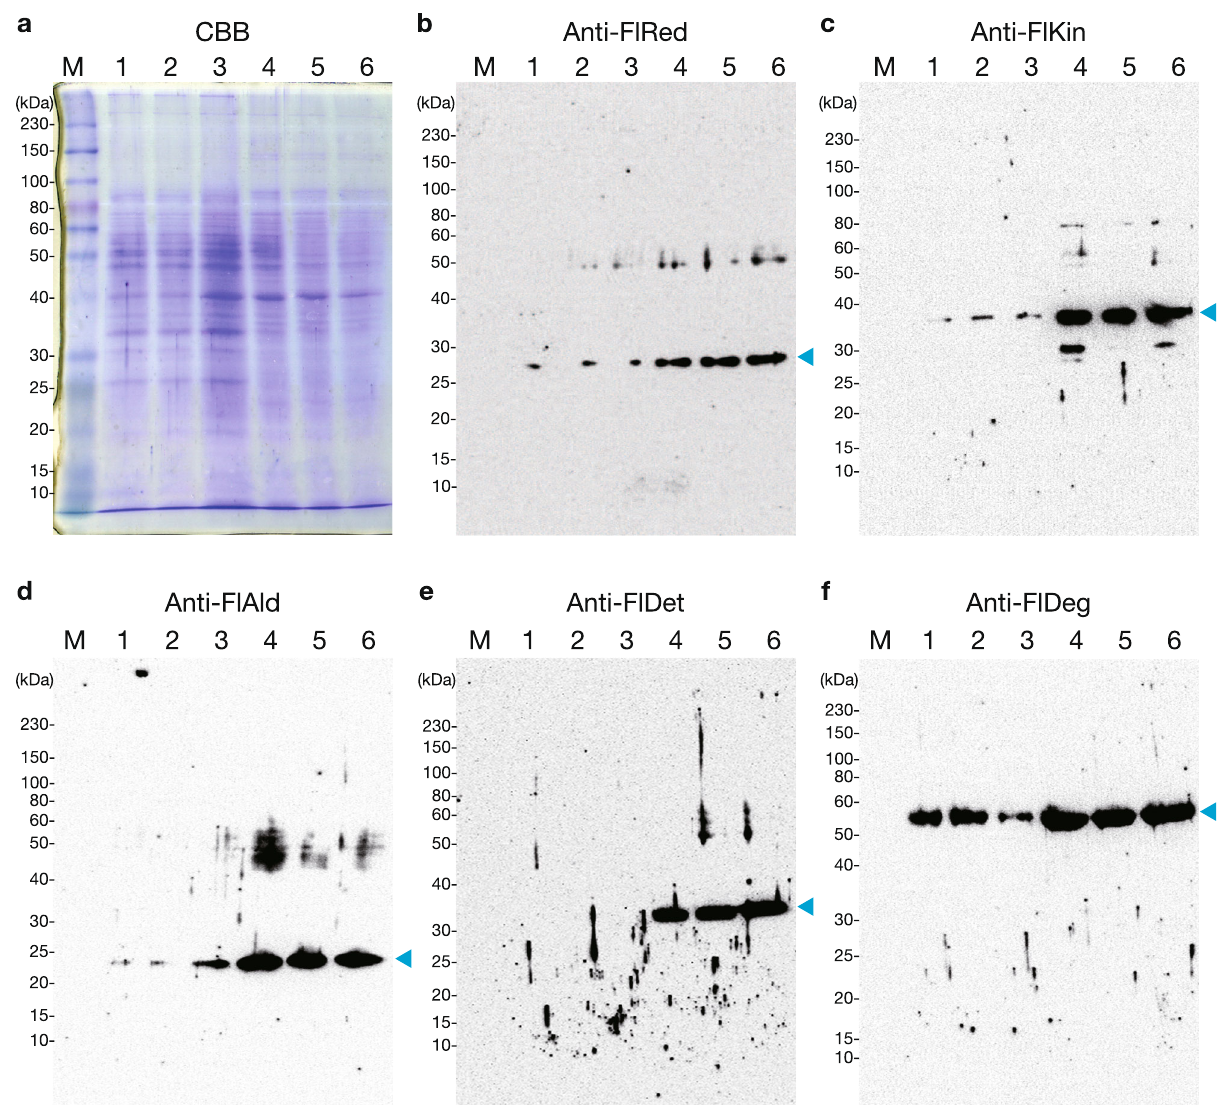
Fig. 4 Western blot analysis of FlRed, FlKin, FlAld, FlDet, and FlDeg. Strain UMI-01 was cultured in a medium containing glucose (lanes 1 – 3) or alginate (lanes 4 – 6) as the sole carbon source. Samples were prepared from three independent cultures for each condition. Lane M, ColorPlus Prestained Protein Ladder, Broad Range (10 – 230 kDa) (New England Biolabs, Ipswich, MA, USA). Each sample was applied to one gel in the order of symmetry. The gel was cut in the middle after electrophoresis, one stained with Coomassie Brilliant Blue R-250 (CBB) and the other transferred to a nitrocellulose fi lter for Western blotting. a CBB-stained gel that was electrophoresed at the same time as the gel transferred on ( b ). Uncropped and unedited CBB-stained gels for each Western blot analysis ( b – f ) are shown in Supplementary Fig. 19. b – f Western blot analysis using anti-FlRed, -FlKin, -FlAld, -FlDet, and -FlDeg antibodies, respectively. The cyan arrowhead indicates the expected migration position of each enzyme. The full-length gel and blots are presented. Blotted fi lters and uncropped images are shown in Supplementary Fig.